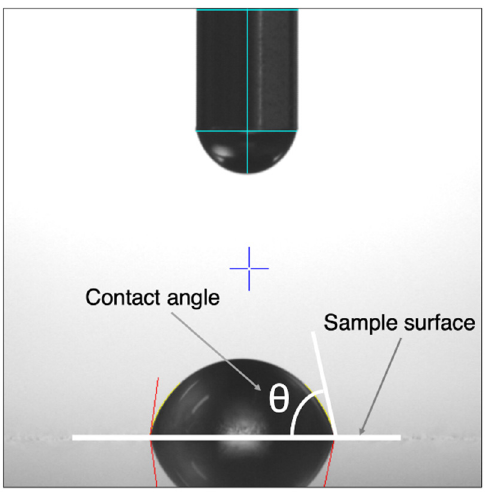
Figure 3. Photograph of the droplet on Ti-15Mo-5Zr-3Al (surface roughness Ra = 0.34, contact angle = 81.43°).